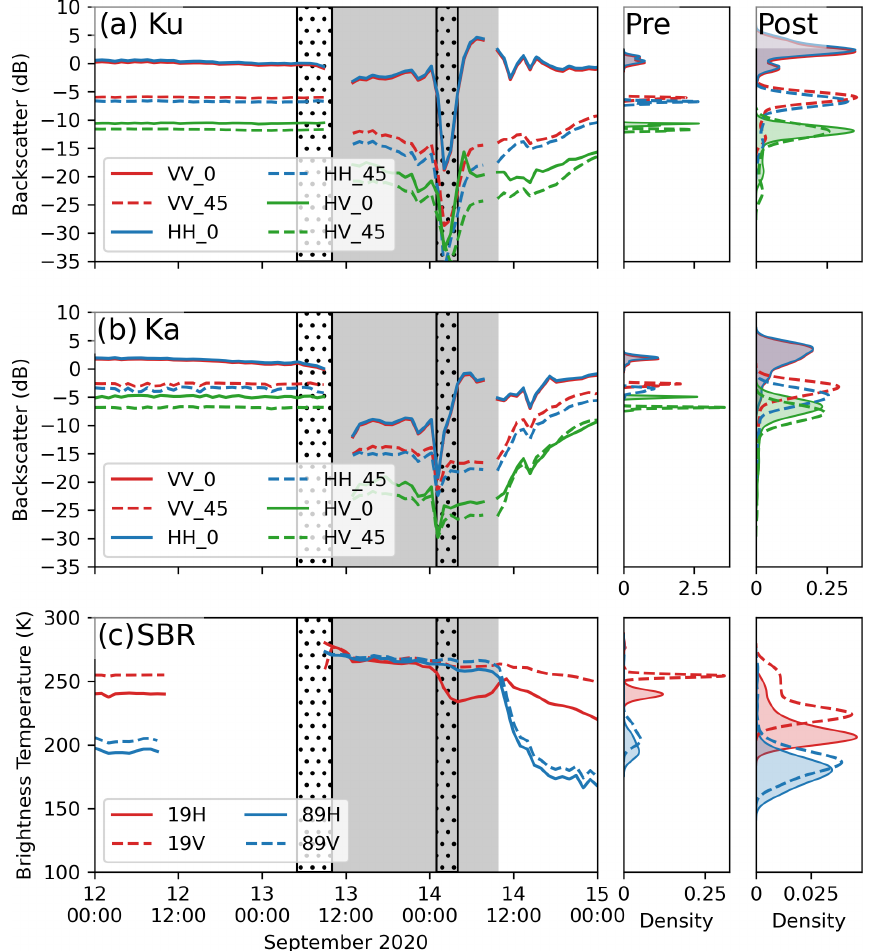
Figure 5. (a) Ku- and (b) Ka-band radar backscatter measured at nadir and θ = 45 ◦ , (c) 19 and 89GHz brightness temperatures at horizontal and vertical polarizations at θ = 55 ◦ . Corresponding kernel density distributions are shown in the right panels before and after the ROS event. Shaded and dotted areas are the same as in Fig. 2. Note the difference of 1 order of magnitude in the kernel density distributions between pre- and post-ROS